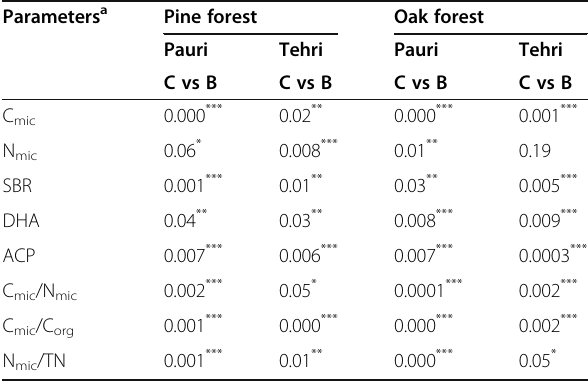
Table 2 Comparison of physicochemical and biochemical properties of soil in oak and pine forests of Tehri and Pauri districts using t test. Entries in the table correspond to p values for the same soil parameters in control (C) and burnt (B)